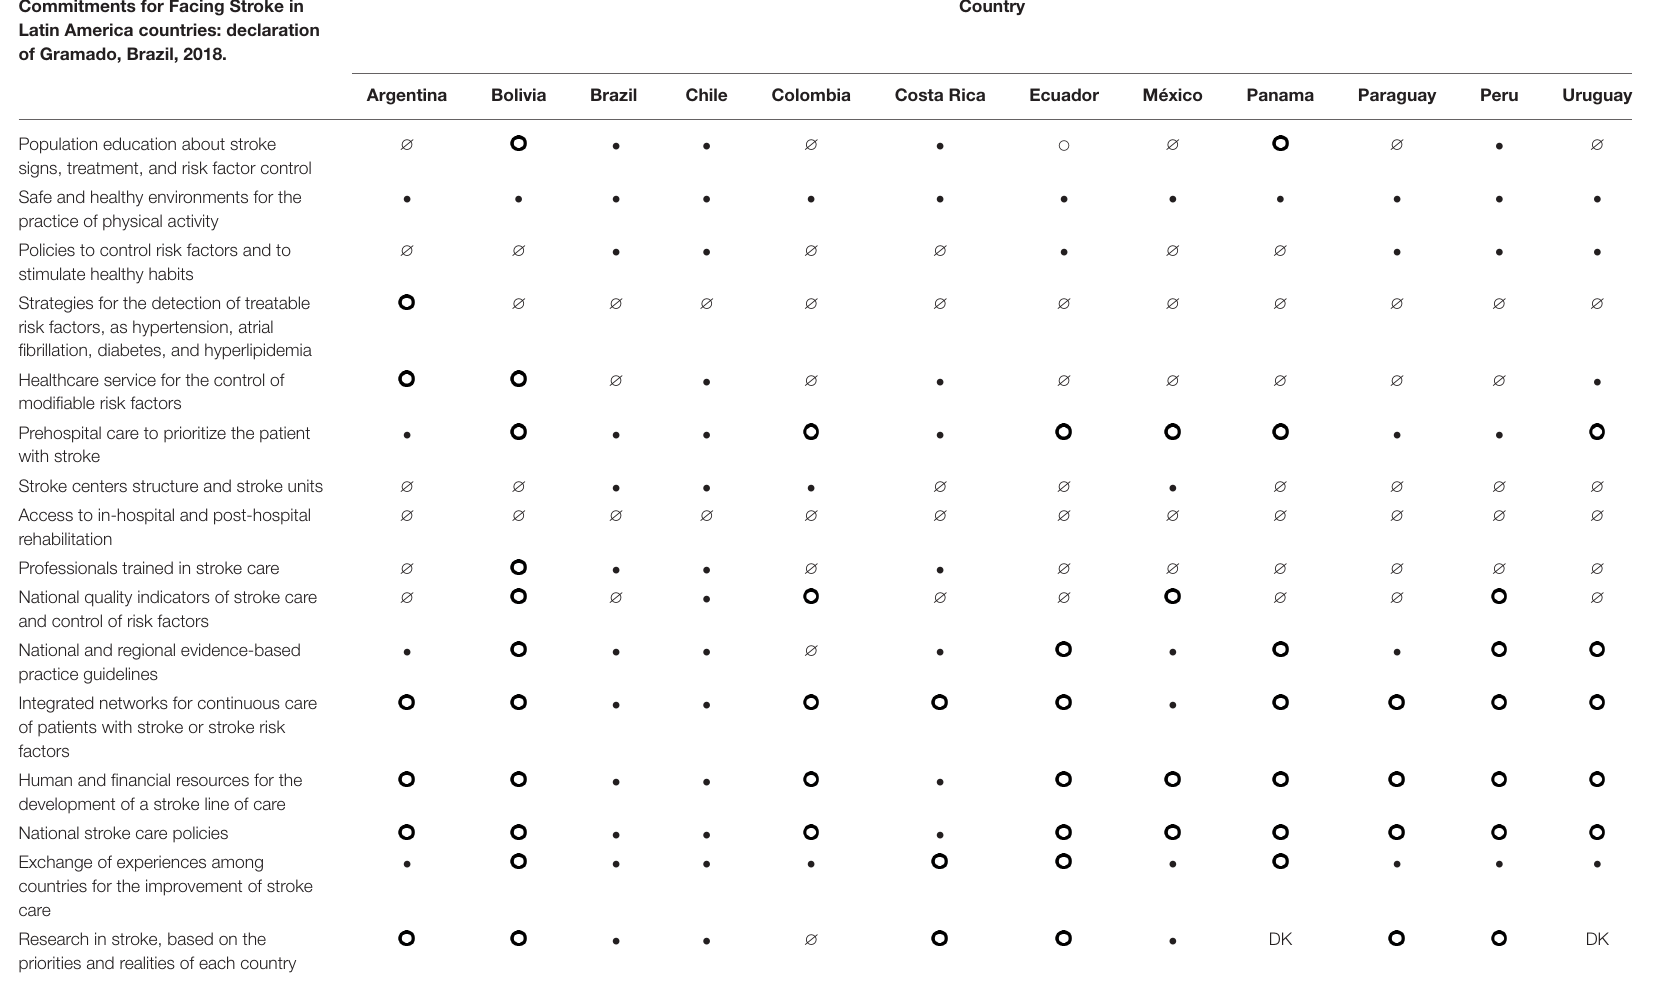
TABLE 3 | Level of achievement of Latin American countries with the commitments of the Declaration of Gramado (2020). Commitments for Facing Stroke in Latin America countries: declaration of Gramado, Brazil,